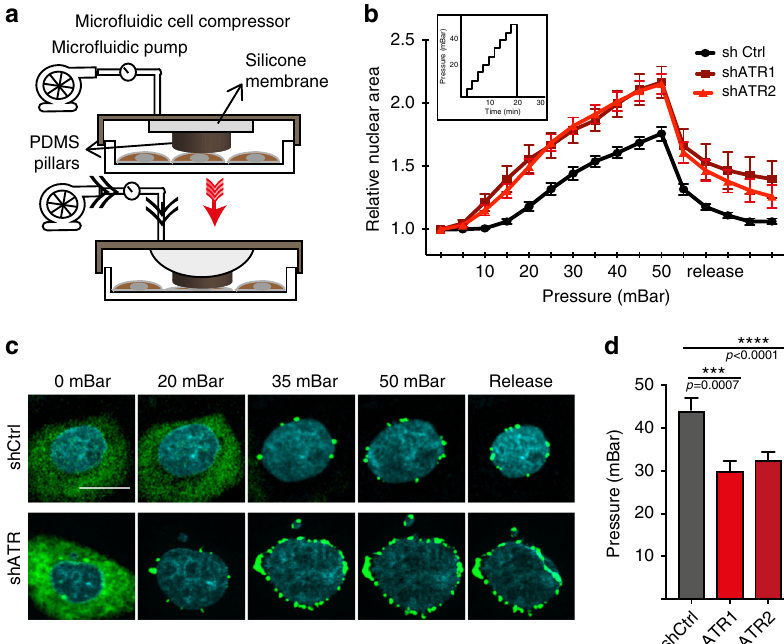
Fig. 3 ATR-defective cells undergo nuclear collapse upon mechanical compression. Mechanical compression using a micro fl uidic compression device. a Design and b graph of compression-induced nuclear deformation with respect to the pressure applied, represented as ratio of its initial uncompressed area. In inlet, graph representing step-wise increase of pressure used for the experiment. c Time-lapse images of perinuclear cGAS foci formation in control and ATR-depleted cells under compression. d Amount of pressure applied through the micro fl uidic pump during the time of NE rupture (formation of fi rst foci of cGAS) ( n = 19, 24, and 21 shCtrl, shATR1, and ShATR2, respectively; data pooled from N = 2 independent replicates). All graphs presented as mean ± SEM. p -values are calculated using two-way ANOVA test and Tukey ’ s multiple comparisons test for b and one-way ANOVA test with Dunnett ’ s multiple comparisons test for d (**** if P < 0.0001, *** if P <